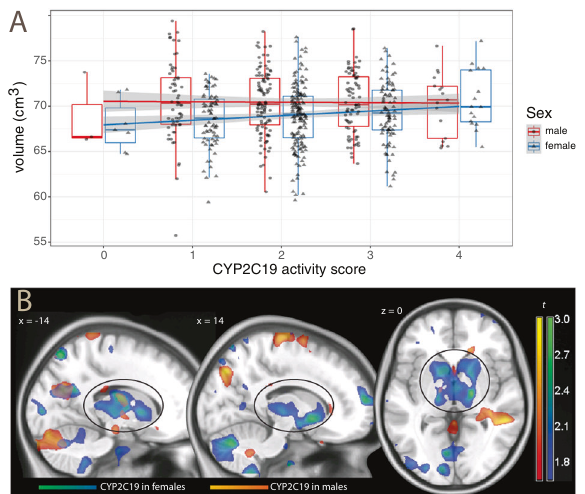
Fig. 3 Sex differences in CYP2C19 activity effects on subcortical brain volume and in deformation-based analysis. A Effects of CYP2C19 activity on subcortical brain volume in males and females. The regression line for males runs essentially fl at (in red), whereas the line for females shows an increase in volume with increasing activity scores (in light blue), so that sexual dimorphism is small or nonexistent in ultrarapid metabolizers (score = 4). Data adjusted for age, site, and cranial volume. B Statistical maps of t values obtained from the voxelwise regression of deformation values on CYP2C19 activity scores in females (in blue-green) and males (red-yellow), thresholded for display purposes at p < 0.05, uncorrected, overlaid on a template brain. Positive t values indicate larger structures. The ovals outline the effects on the basal